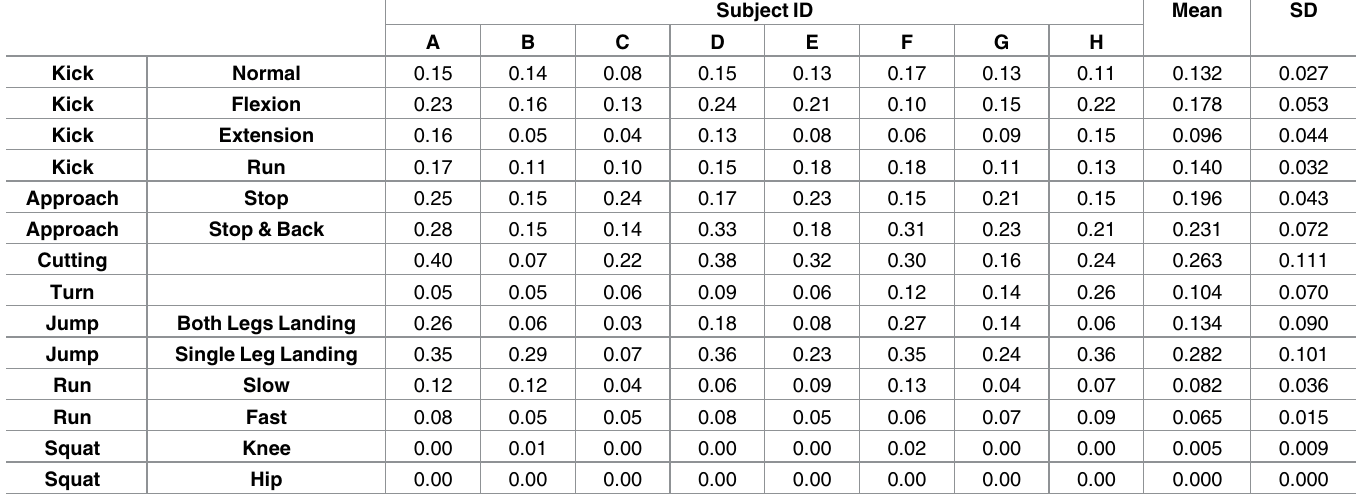
Landing". Fig 4 ranks the mean angular impulse of the knee extension moment greater than or equal to 2.0 Nm/kg in descending order. The motion with the highest mean angular impulse greater Table 2. Angular impulse of the knee extension moment per test subject for each motion. Note that the angularimpulsein this study is the integral of the moments that are greater than or equal to 1.0 Nm/kg